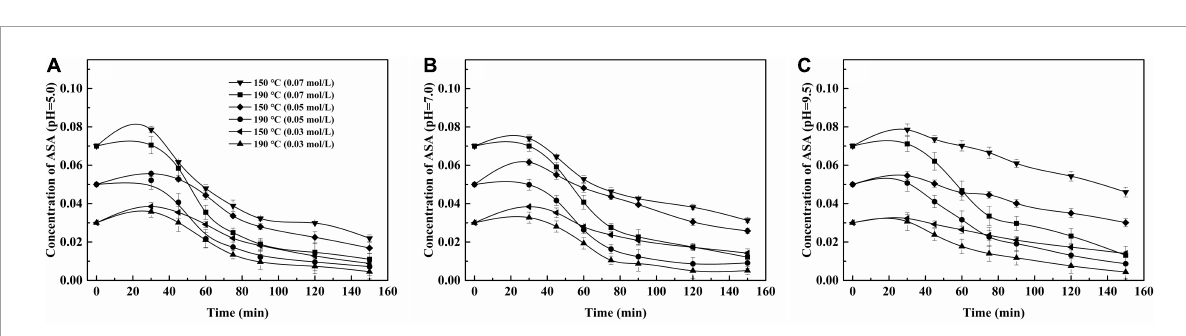
FIGURE2 Effect of reaction parameters on the self-degradation of ASA under two temperatures. (A) pH = 5.0; (B) pH = 7.0; (C) pH =